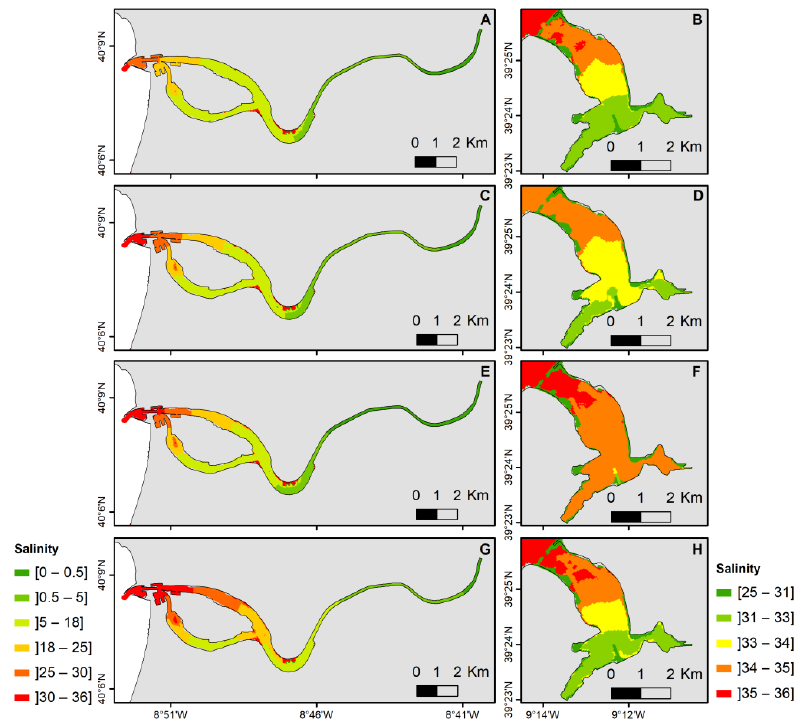
Figure 10. Seasonal mean of salinity for Mondego Estuary (left) and Ó bidos Lagoon (right): ( A , B )—winter; ( C , D )—spring; ( E , F )—summer; ( G , H )—autumn.